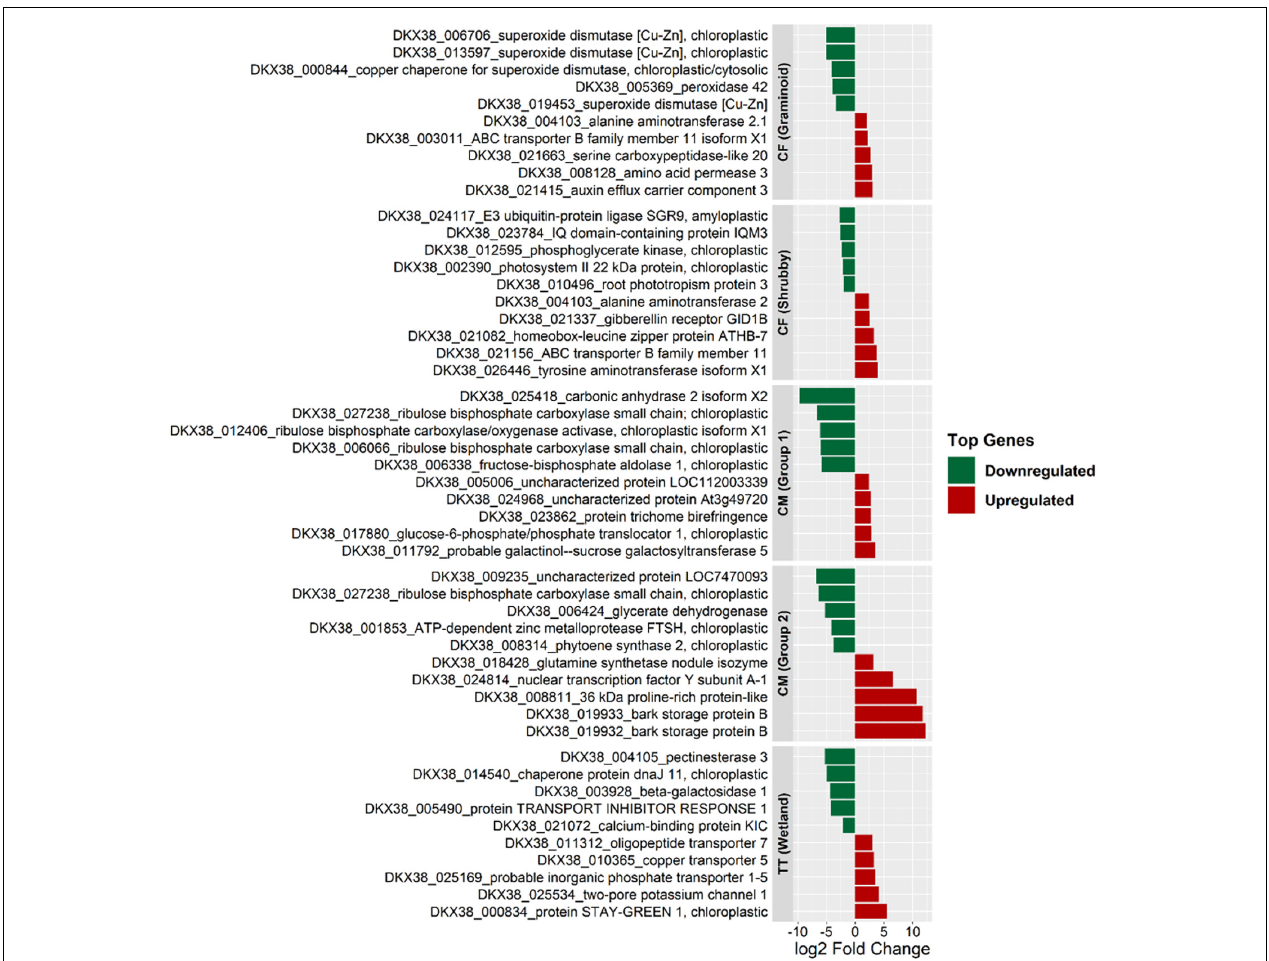
FIGURE 3 | Gene expression and annotation of top 10 highly impacted genes (i.e., with highest log2 fold change in treatments compared to control in each group) of willow grown in different types of oil sands tailings with no reclamation cap or 5 cm of reclamation cap (treatments) compared with ≥ 30 cm of reclamation